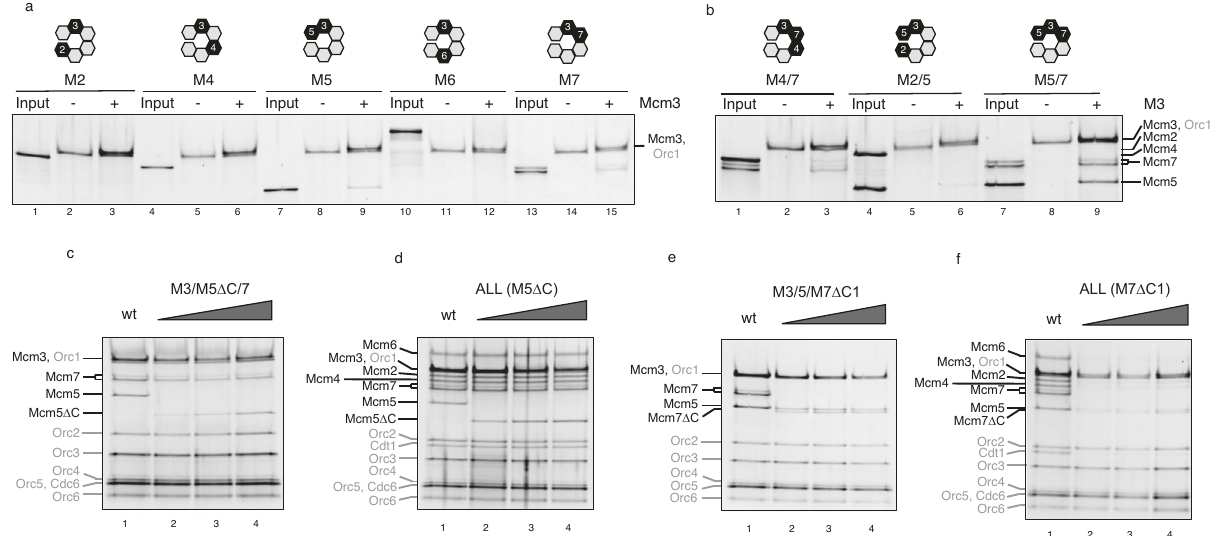
Fig. 1 Mcm7 C-WHD is required for MCM-Cdt1 recruitment. a The recruitment of the individual Mcm subunits (M2, 4, 5, 6 and 7) by the OC complex (ORC and Cdc6 bound to a PCR product containing ARS305 and 1049 bp long) was followed using recruitment conditions (ATP γ S and low salt washes), under the presence ( + ) or absence ( − ) of Mcm3. 20% of each Mcm subunit tested is shown in the input lane. Relative position in the Mcm2-7 ring, of Mcm3 and the subunit tested, are highlighted in black at the top of the fi gure. Note that the Orc1 subunit and Mcm3 run in similar positions in the gel. b Neighbouring dimers of Mcm3 are tested for recruitment, as in a . c Recruitment of the trimer, Mcm5/3/7, using either Mcm5wt (wt) or increasing amounts of an Mcm5 containing a deletion of the C terminus winged helix domain (C-WHD, M5 Δ C). Loading factors are labelled in grey and Mcm2-7 in black. d Recruitment of the heptameric MCM-Cdt1 complex containing either Mcm5 wt (lane 1) or with increasing amounts of M5 Δ C (lanes 2 –